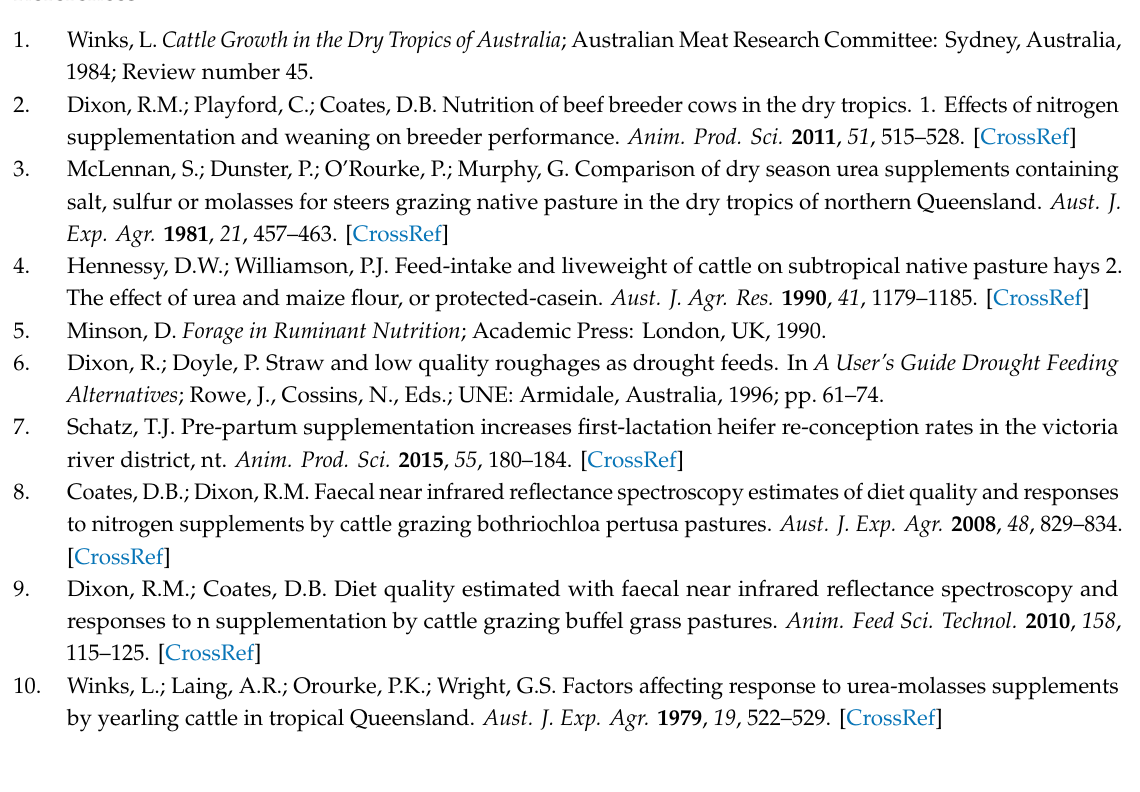
S3: Primers used for amplicon library preparation. Figure S1: Experiment timeline diagram, Figure S2: Alpha diversity measures for rumen bacteria (a), archaea (b), protozoa (c), and fungi (d) communities at un-supplemented and supplemented animals illustrating the Chao1 index (Chao1), Shannon diversity index (Shannon), and Simpson diversity index (Simpson), Figure S3: Supervised analysis with sPLS-DA on rumen bacteria (a), archaea (b), protozoa (c), and fungi (d) communities for un-supplemented and supplemented animals grazing in mid-dry, late-dry season, and wet season, Figure S4: Quantitative PCR analysis of rumen anaerobic fungi and protozoa population changes in response to supplementation in the late-dry season. t denotes a tendency ( p < 0.1) of supplemented group compared to the un-supplemented group. The y-axis denotes fold change relative to un-supplemented animals’ fungi and protozoa populations respectively, Figure S5: Alpha diversity measures for rumen bacteria (a), archaea (b), protozoa (c), and fungi (d) communities from animals grazing in the mid-dry and wet seasons illustrating the Chao1 index (Chao1), Shannon diversity index (Shannon), and Simpson diversity index (Simpson), Figure S6: Quantitative PCR analysis of rumen anaerobic fungi and protozoa population changes in animals grazing at the mid-dry and wet season. *** Denote significant di ff erences ( p < 0.01) of wet season compared to the mid-dry season. The y-axis denotes fold change relative to the mid-dry season fungi and protozoa populations, respectively, Supplementary File S1: Bacterial ASVs significantly di ff erent (FDR < 0.05) between un-supplemented and supplemented animals in the late-dry season. Supplementary File S2: Archaeal ASVs significantly di ff erent (FDR < 0.05) between un-supplemented and supplemented animals in the late-dry season. Supplementary File S3: Bacterial ASVs significantly di ff erent (FDR < 0.05) between animals grazing in the mid-dry and wet seasons. Supplementary File S4: Archaeal ASVs significantly di ff erent (FDR < 0.05) between animals grazing in the mid-dry and wet seasons. Supplementary File S5: Protozoal ASVs significantly di ff erent (FDR < 0.05) between animals grazing in the mid-dry and wet seasons. Supplementary File S6: Fungal ASVs significantly di ff erent (FDR < 0.05) between animals grazing in the mid-dry and wet